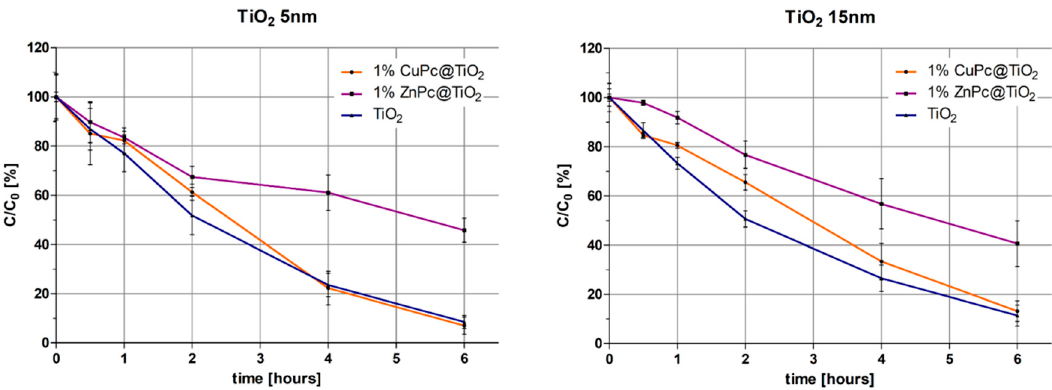
Figure 7. The changes in ibuprofen concentration after irradiation (365 nm light) of the solution containing a photocatalyst.